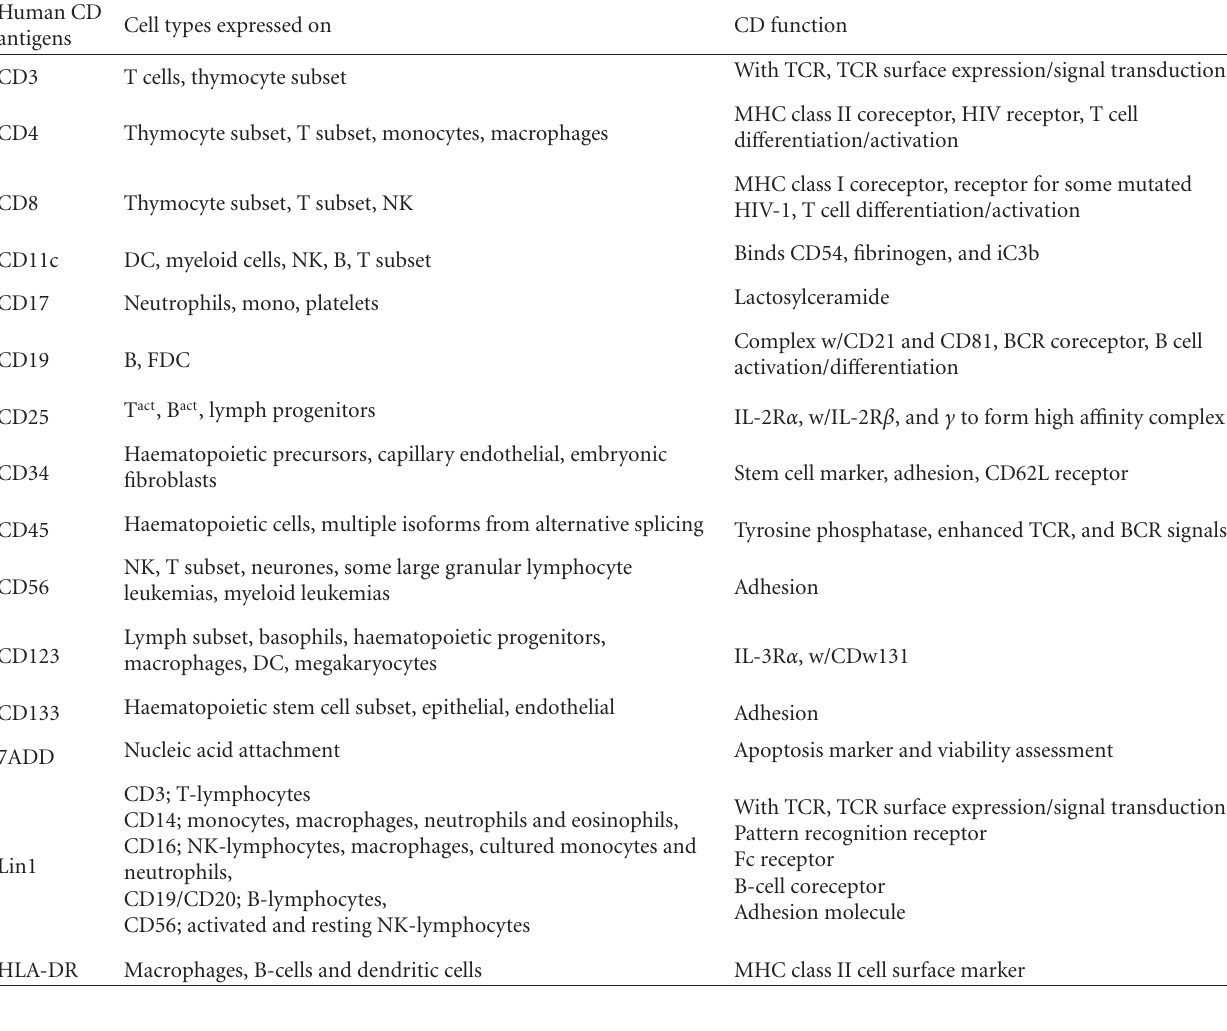
Table 1: Important surface markers for quantification of human umbilical cord blood content.